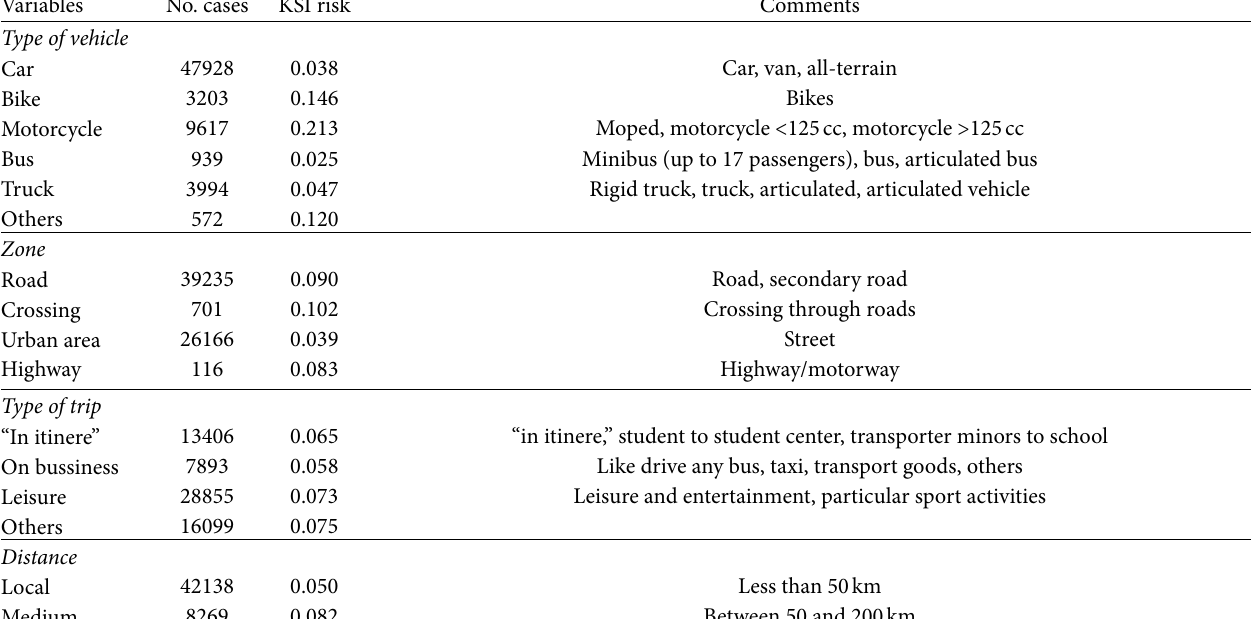
Table 1: Number of cases and a priori probability of the severity of the injury based on behavior variables. Processed by the authors.